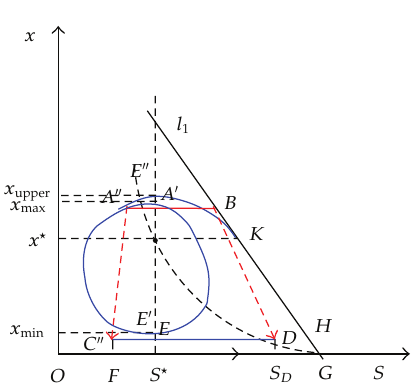
Figure 5: Illustration of system (cid:5) 2.6 (cid:6) for the case where x (cid:2) ≤ x set ≤ x max